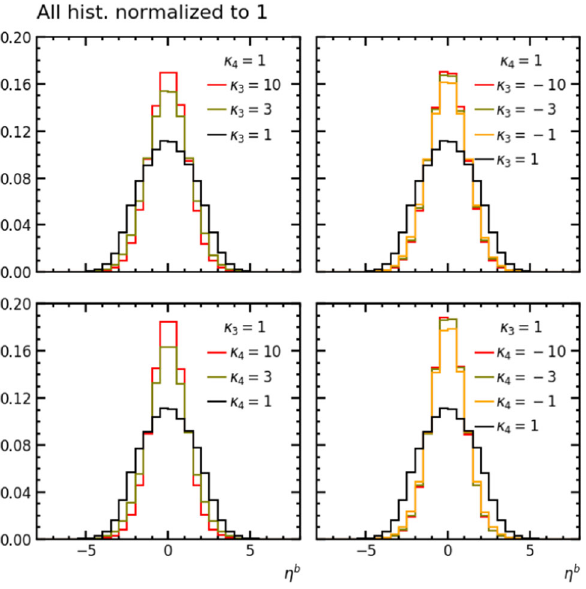
Fig. 35 Distribution of e + e − → b ¯ bb ¯ bb ¯ b ν ¯ ν events with respect to the pseudorapidity of the b -jets, for several values of the parameters κ 3 and κ